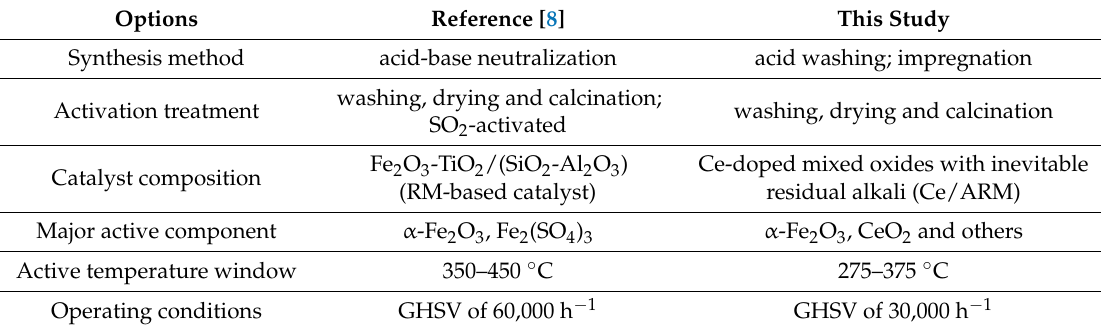
Table 4. Comparison of works.